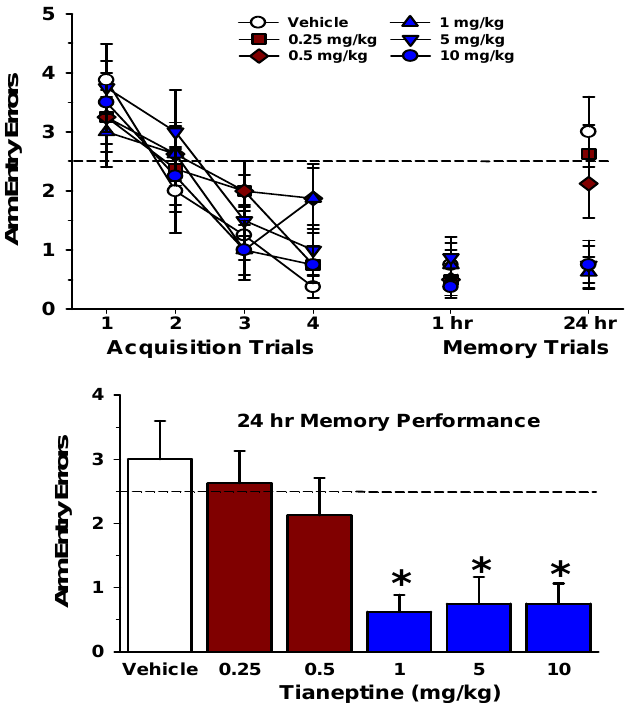
Figure 1. Pre-training administration of tianeptine enhanced long-term (24-hours) spatial memory in the